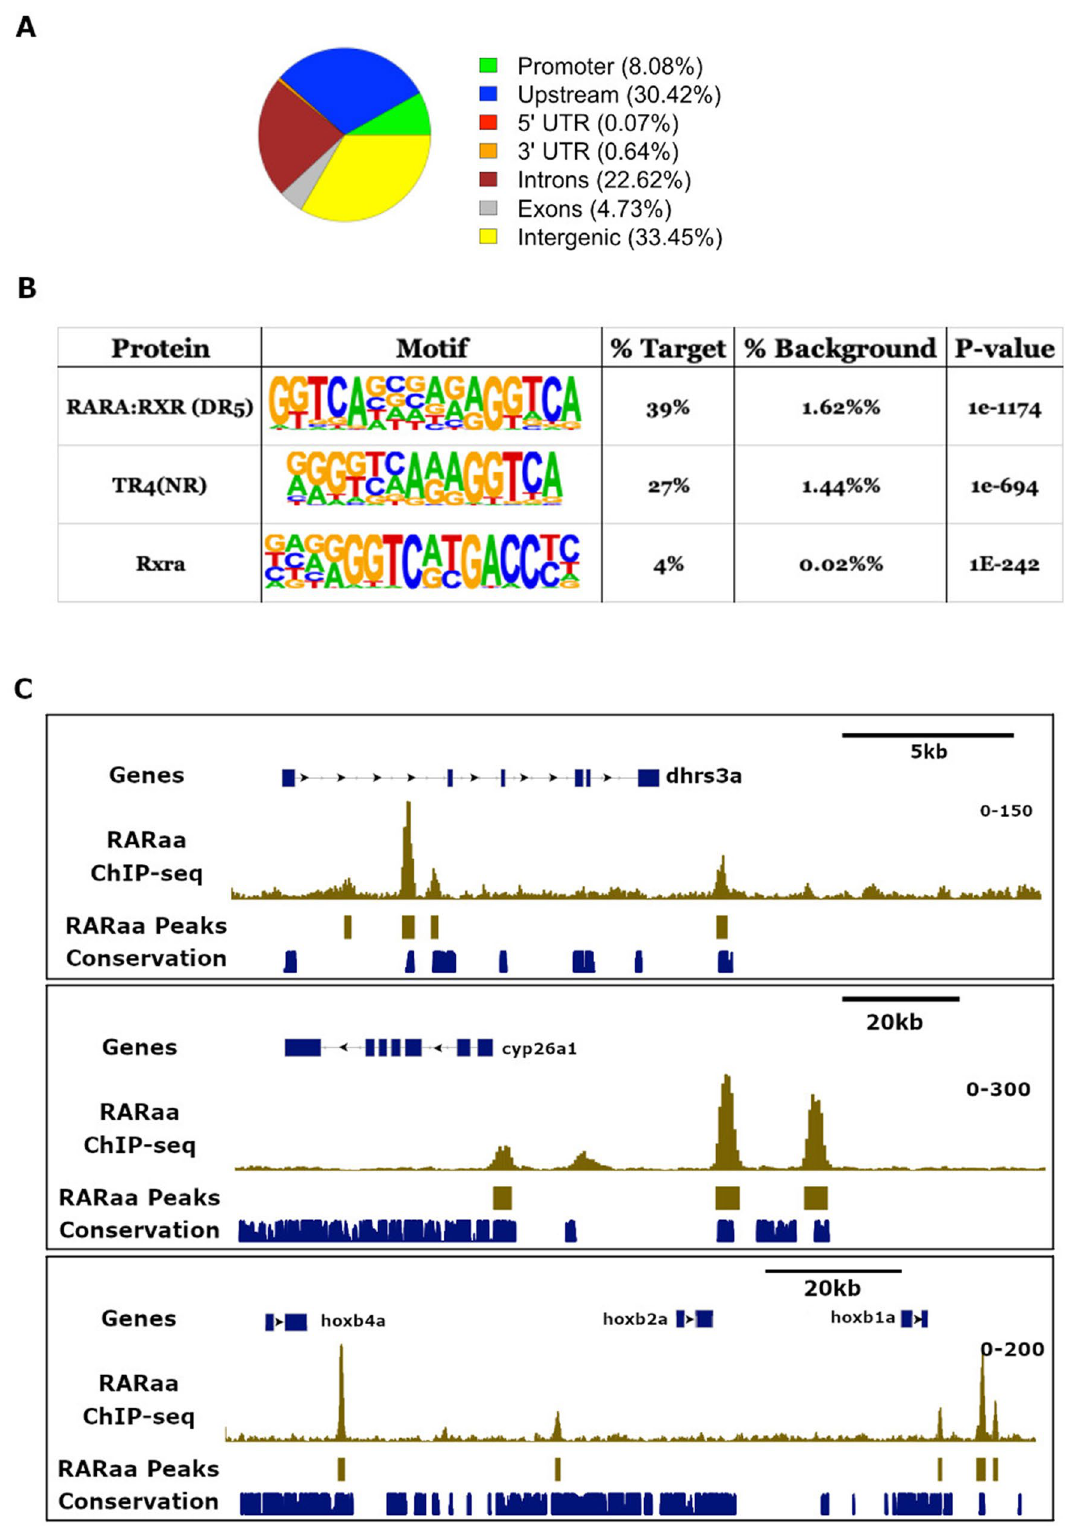
Figure 2. Identification of RAR binding sites in the zebrafish endoderm. ( A ) Distribution of ChIP-seq peaks to the different regions of the zebrafish genome. ( B ) Top 3 motifs overrepresented in all ChIP-seq peak sequences with the percentage of sites containing the motifs and the p-value of enrichment. The three motifs consist to a repetition of the A/GGG TCA sequence; the first corresponds to the classical DR5 recognized by the RARA:RXR complex, the second (TR4) is a superposition of DR1 and DR2, and the third is a IR0. ( C ) Visualization of RARaa binding sites around the dhrs3a gene (upper panel), cyp26a1 (middle panel) and hoxb1a-hoxb4a genomic region (below panel). Tracks in gold correspond to RARaa ChIP-seq reads and identified RARaa peaks. The track in blue shows the location of conserved genomic sequences (from the UCSC Genome Browser obtained from comparison of 5 fish